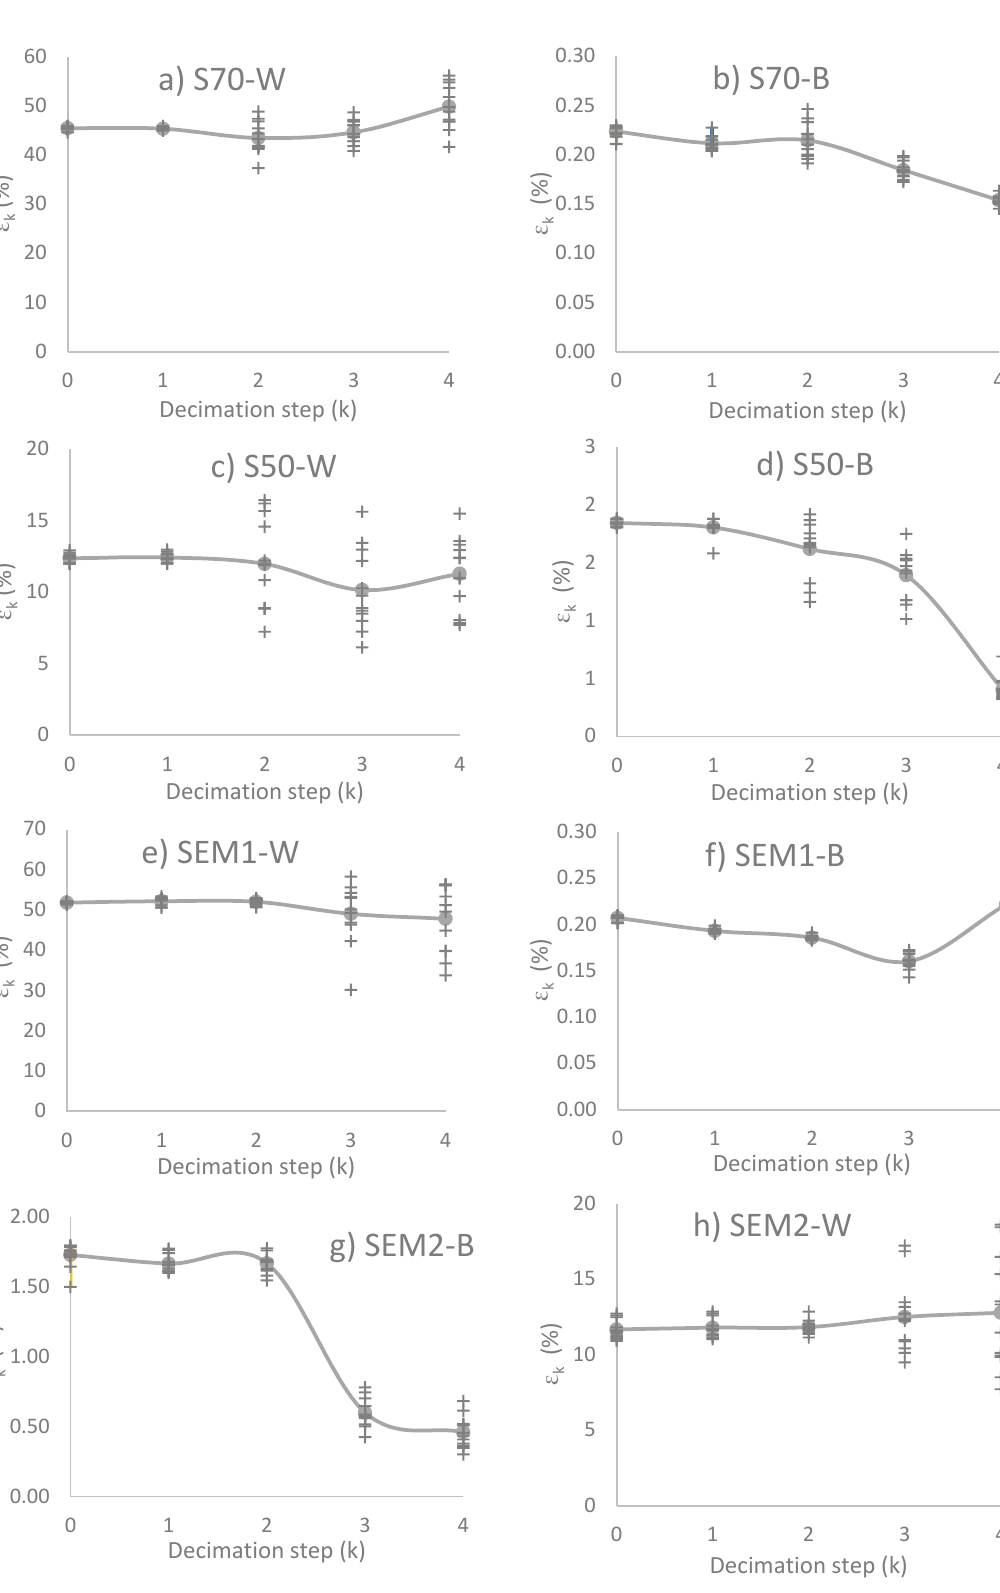
Figure 7. Conduction Efficiency ( ε k ). ( a ): White phase of S70 image, ( b ): Black phase of S70 image, ( c ): White phase of S50 image, ( d ): Black phase of S50 image, ( e ) White phase of SEM1 image, ( f ): Black phase of SEM1 image, ( g ): White phase of SEM2 image, ( h ): Black phase of SEM2 image. The change in image resolution, due to intentional decimation, modifies the average 𝜀 (cid:3038) value and the standard deviation value. For each material, when 𝑘 = 1 , the 𝜀 (cid:3038) average is statistically